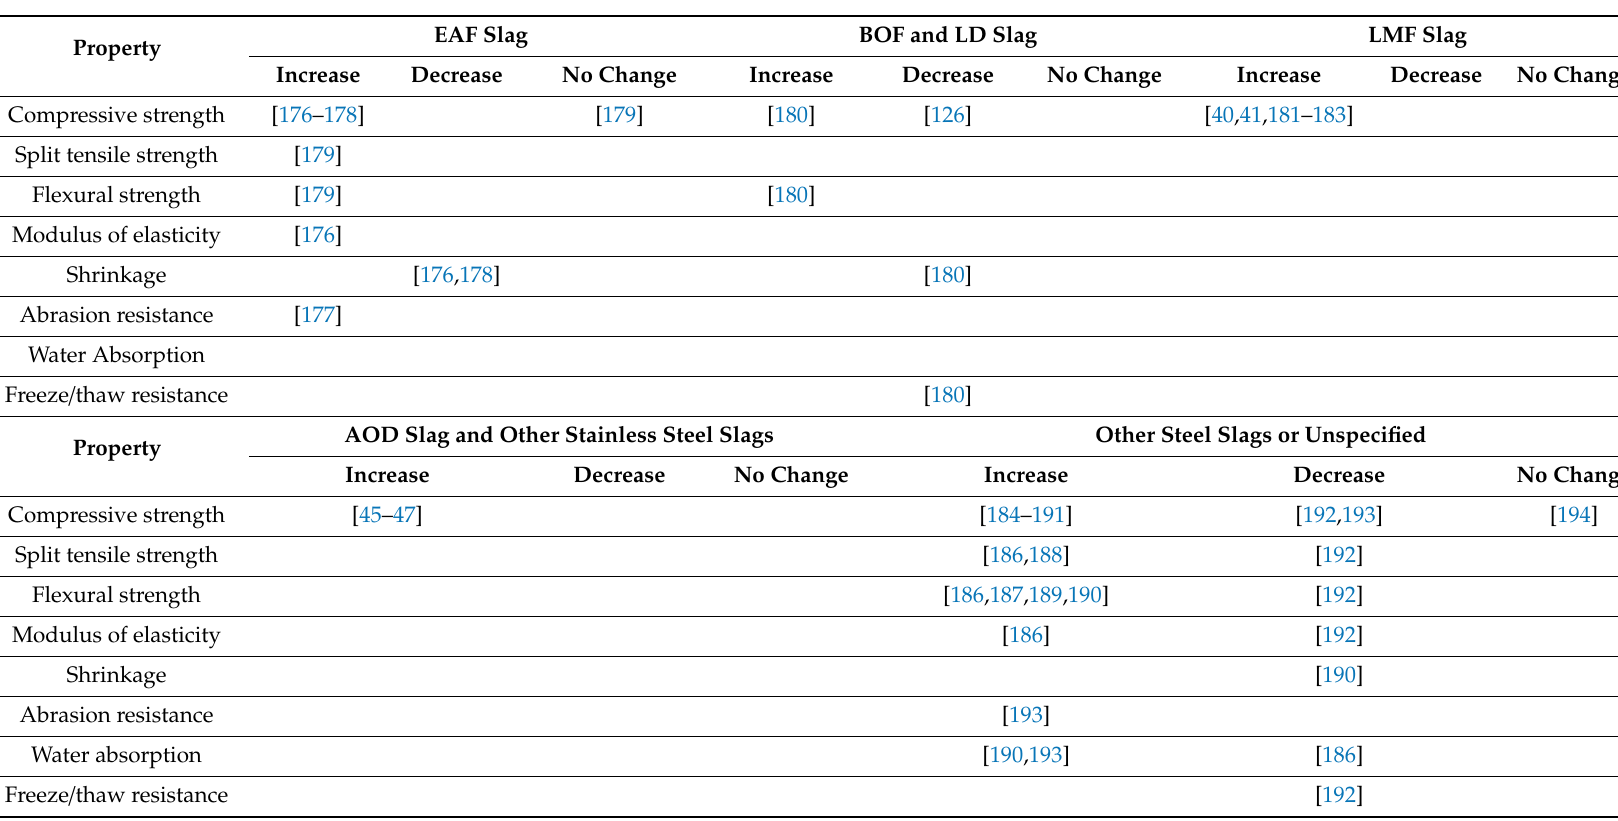
Table 3. E ff ect of SFS used as a partial to full replacement of virgin coarse and / or fine aggregate in geopolymer or alkali-activated mortars or concretes relative to the control with virgin